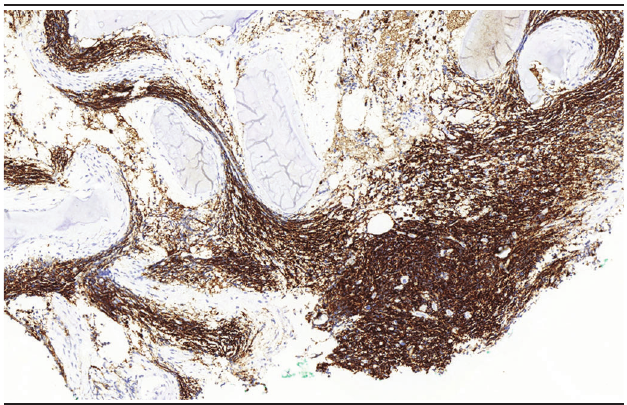
figurE 4 − Bone marrow biopsy, immunohistochemistry (CD79a, 200×) Positivity for CD79a indicates the immunophenotype B of the neoplasm.